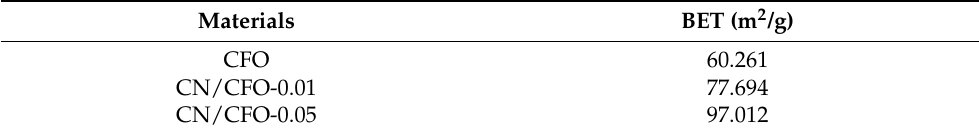
Table 1. The specific surface area of the